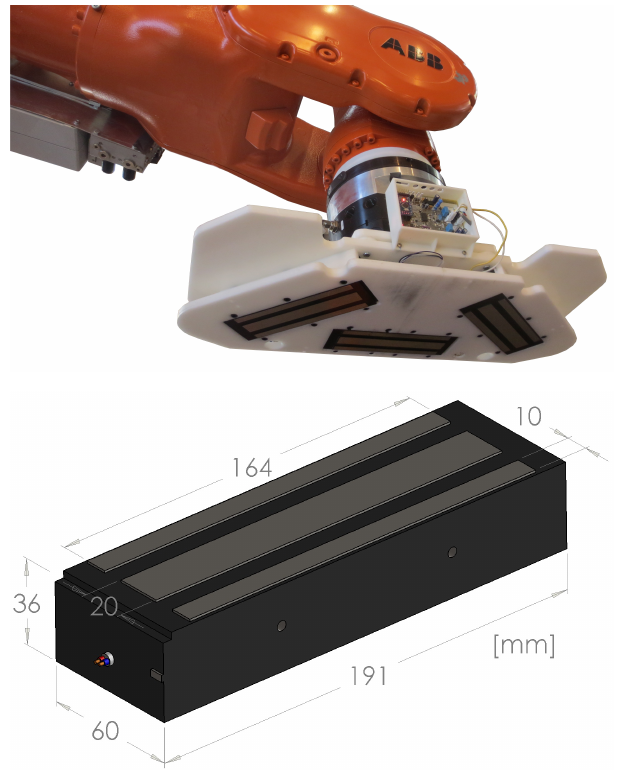
Figure 2. ( Top ) Prototype electromagnet tool made of PTFE plastic and mounted on the IRB-6650S robot. A total of three electromagnets were mounted in the tool; ( Bottom ) Simplified CAD model of the used electromagnets. The top surface shows the open ends of the laminated